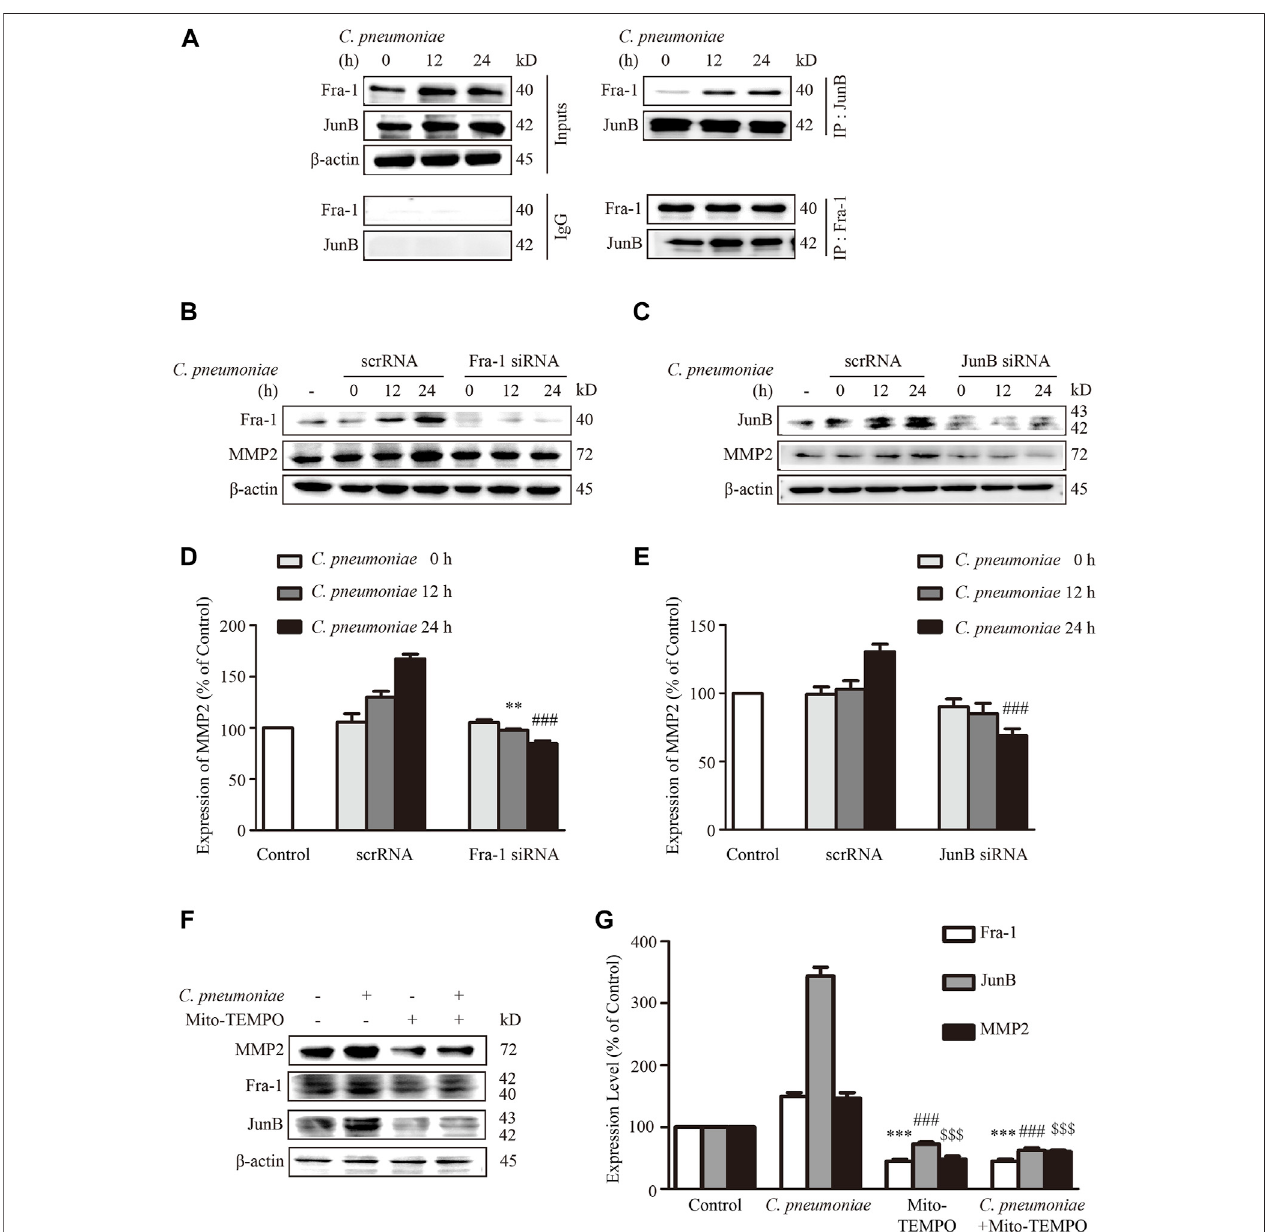
FIGURE6| C.pneumoniae infectionincreasesMMP2expressionthroughactivatingJunBandFra-1bymtROS. (A) VSMCswereinfectedwith C.pneumoniae (5× 10 5 IFU) for 24 h. Cell lysates were immunoprecipitated with anti-Fra-1 antibody or anti-JunB antibody, and then Western blot was performed. IP, immunoprecipitation. Inputs were used as controls. (B) Representative Western blot images of Fra-1 and MMP2 from VSMCs pretreated with Fra-1 speci fi c siRNA and infected with C. pneumoniae for the indicated timepoints. (D) The expression ratio of MMP2 to β -actin from three independent experiments is presented. ** p < 0.01, compared with C. pneumoniae infection 12 h and scrRNA groups, asanalyzed byStudent ’ s t -test. ### p < 0.001, compared with C. pneumoniae infection 24 hand scrRNAgroup, as analyzed by Student ’ s t -test. (C) Representative Western blot images of JunB and MMP2 from VSMCs pretreated with JunB speci fi c siRNA and infected with C.pneumoniae fortheindicatedtimepoints. (E) TheexpressionratioofMMP2to β -actinfromthreeindependentexperimentsispresented. ### p < 0.001,comparedwith C. pneumoniae infection 24 h and scrRNA group, as analyzed by Student ’ s t -test. (F) Representative Western blot images of Fra-1, JunB, and MMP2 from VSMCs pretreated with Mito-TEMPO and with or without C. pneumoniae infection. (G) The expression ratio of Fra-1, JunB and MMP2 to β -actin from three independent experiments is presented. *** p < 0.001, compared with C. pneumoniae infection 24 h and Fra-1 groups, as analyzed by Student ’ s t -test. ### p < 0.001, compared with C. pneumoniae infection 24 h and JunB group, as analyzed by Student ’ s t -test. $$$ p < 0.001, compared with C. pneumoniae infection 24 h and MMP2 group, as analyzed by Student ’ s t